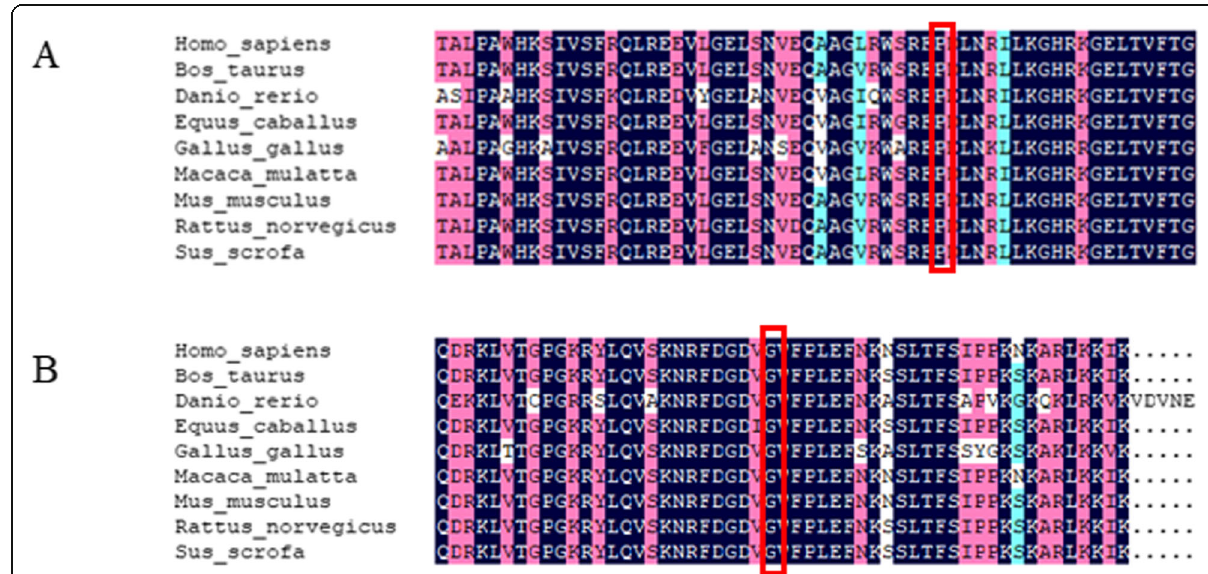
Fig. 2 Conservation of protein sequence at 2 residues with mutations in this family (Mutated residues are framed in red). ( a ) Conservation of p.Pro396Ser ( b ) Conservation of